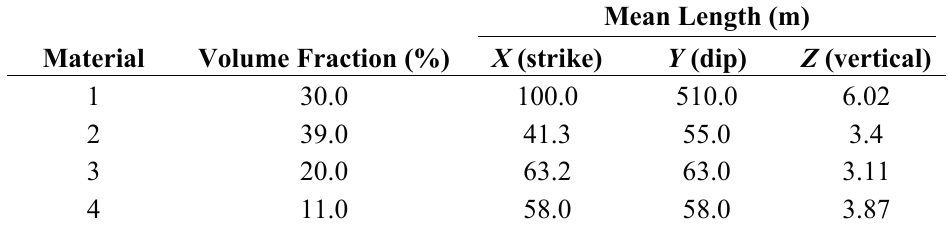
Table 2. Proportions of materials and the corresponding mean lengths utilized for the T-PROGS simulations.